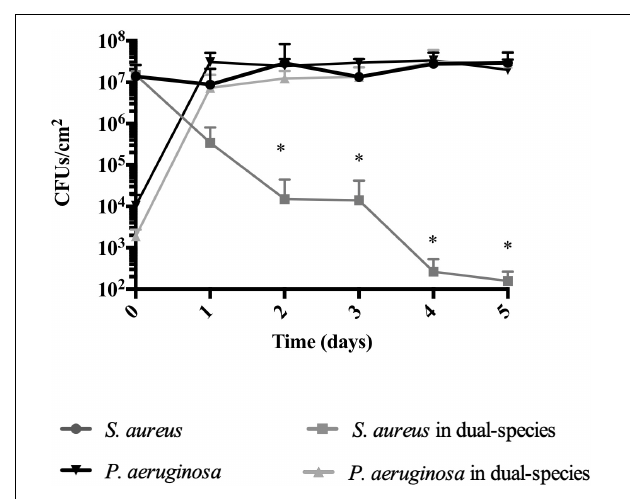
FIGURE 3 | Staphylococcus aureus persists in dual-species biofilms when co-inoculated with P. aeruginosa . Dual-species biofilms were initiated on a polystyrene surface with S. aureus and P. aeruginosa at a concentration of 250:1. Biofilm growth was monitored for a period of 5 days under several conditions: 20% BHI at 37 ◦ C under agitation at 220 rpm. Media was replaced at 12 h intervals and bacterial viability and strain ratios were evaluated daily. Controls consisted of biofilms of axenic cultures. Bacterial viability and strain ratios were evaluated daily. ∗ p < 0.001 comparing to the axenic culture.